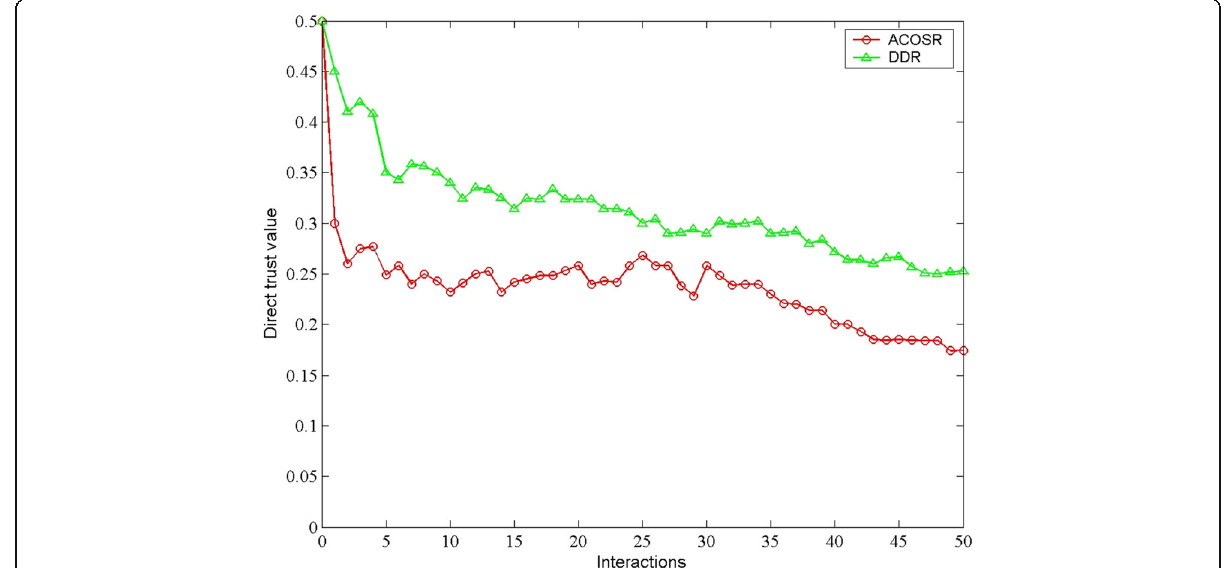
Fig. 3 Direct trust value in the case of malicious node ’ s